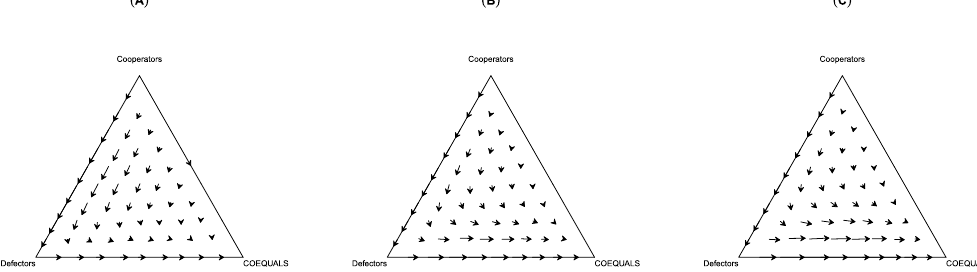
Figure 1. Evolutionary dynamics of COEQUALS, defectors, and cooperators. Figure 1 presents phase diagrams reporting evolutionary dynamics in the baseline model when b = 2 [Panel (A)], b = 3 [Panel (B)], and b = 4 [Panel (C)], and all other parameters—save for population size—are set to their median values. In Panels (A–C), simplex vertices represent states in which all agents in the population adopt the adjacently listed strategy. Points along a simplex’s edges signify states in which agents adopt some combination of two strategies, whereas points within the simplex represent states in which agents adopt some combination of three strategies. Arrows indicate the population’s trajectory and the length of an arrow’s tail indicates the speed of population change, with longer tails signifying faster population change. Panel (A) indicates that the population gravitates toward COEQUALS more rapidly when a substantial portion of the population consists of defectors. For instance, when b = 2, P D g = 0.1, and P C g = 0.8, the proportion of the population adopting COEQUALS grows by only 1% over a generation. However, when b = 2, P D g = 0.8, and P C g = 0.1, the proportion of the population adopting COEQUALS grows by roughly 15% over a generation. Indeed, even when b = 2, COEQUALS grows to fixation from a state of universal defection ( P D g = 1, P C g = 0). As Panel (B and C) indicate, when the gains to cooperation increase, agents adopt COEQUALS at a faster rate and a smaller proportion of defectors in the population are needed for a rapid advance toward universal adoption. In comparison with the above analysis, Panel (B) indicates that when b = 3, the proportion of COEQUALS adopters grows by 15% over a generation when P D g = 0.50 and the proportion of COEQUALS adopters grows by 33% when P D g = 0.80 and P C g = 0.1. When b = 4 [Panel (C)], the percent growth of COEQUALS adopters reaches 15% when P D g = 0.39. At P D g = 0.80 and P C g = 0.10, COEQUALS grows by 53% over the course of a